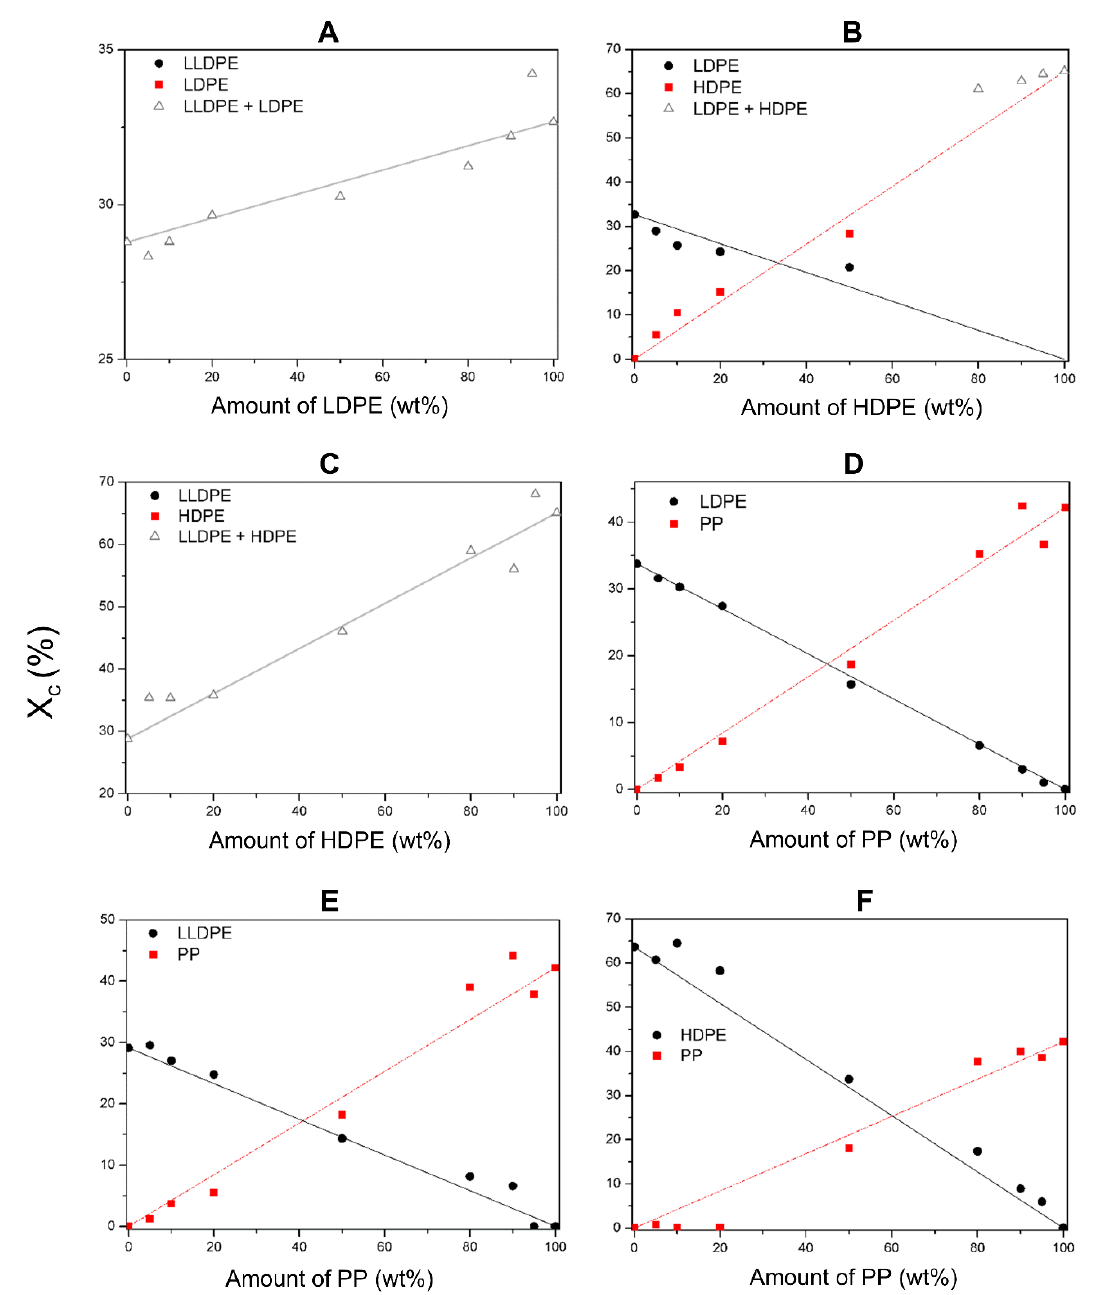
Figure 1. Crystallinity of all blends: ( A ) LLDPE + LDPE; ( B ) LDPE + HDPE; ( C ) LLDPE + HDPE; ( D ) LDPE + PP; ( E ) LLDPE + PP; ( F ) PP + HDPE. The symbols represent the experimental measured values. Lines present the predictions ( ____: prediction of Δ, ____: prediction of ●, _ _ _: prediction of ■ ). The predictions are calculated using the rule of mixtures (Equation (1)), based on the crystallinities of the mono materials. The data points are the averages of two measurements.